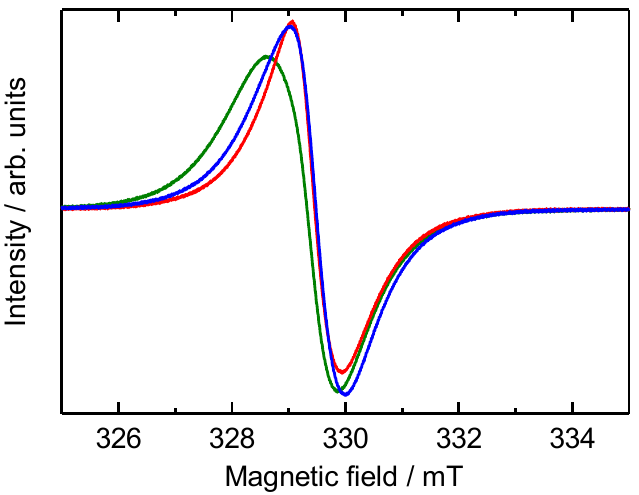
Figure 4. ESR results during early stages of in-situ vapor phase doping of PANI/pulp with iodine. Changes in g- value, ESR intensity ( I